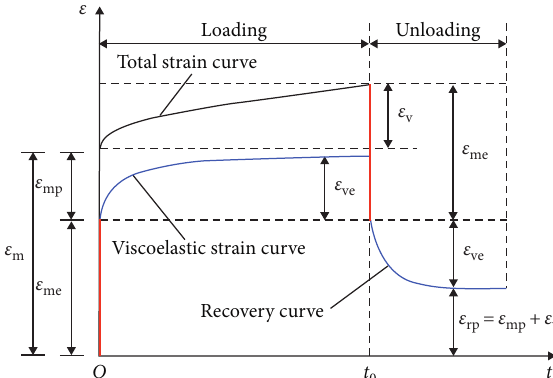
Figure 1: Typical creep curve during the loading and unloading test.